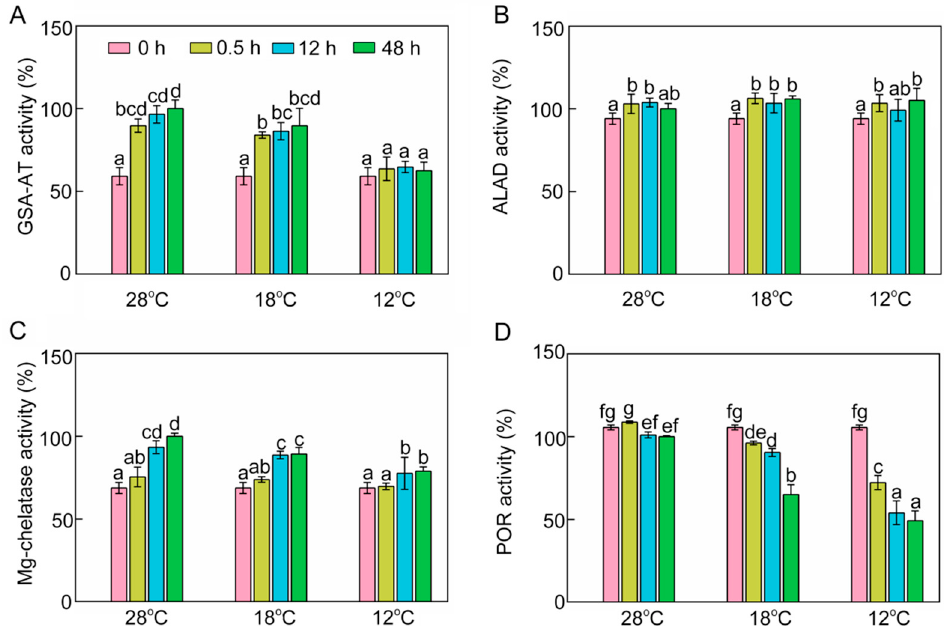
Figure 4. E ff ects of chilling stress (18 ◦ C and 12 ◦ C) on activities of enzymes involved in chlorophyll biosynthesis. Glutamate-1-semialdehyde transaminase (GSA-AT, A ), ALA dehydratase (ALAD, B ), Mg-chelatase ( C ), protochlorophyllide oxidoreductase (POR, D ) activities of control (28 ◦ C) and chill-stressed (18 ◦ C and 12 ◦ C) rice seedlings after 0 h, 0.5 h, 12 h, and 48 h greening. Six day old etiolated seedlings were treated with 18 ◦ C or 12 ◦ C chilling stress. Seedlings were harvested at 0 h, 0.5 h, 12 h, and 48 h of greening and their activities of enzymes involved in chlorophyll biosynthesis were measured. The activities of enzymes at 28 ◦ C after 48 h of light exposure were defined as 100%. Values are means ± SD from three independent biological replicates. Di ff erent letters indicate significant di ff erences according to Duncan’s multiple range tests at p < 0.05. Each data point is the average of three replicates. The error bars represent